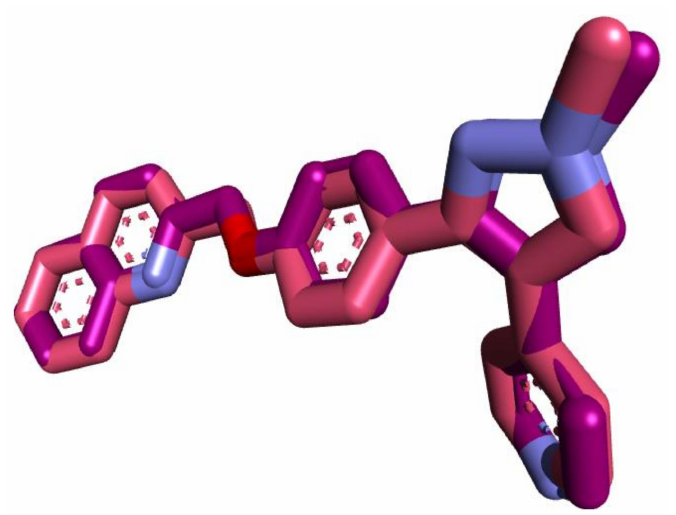
Figure 6. Validation of docking protocol by cognate redocking of the co-crystallized ligand of 3HR1; co-crystallized conformation (pink) compared to the re-docked conformation (purple) of native ligand in three-dimensional